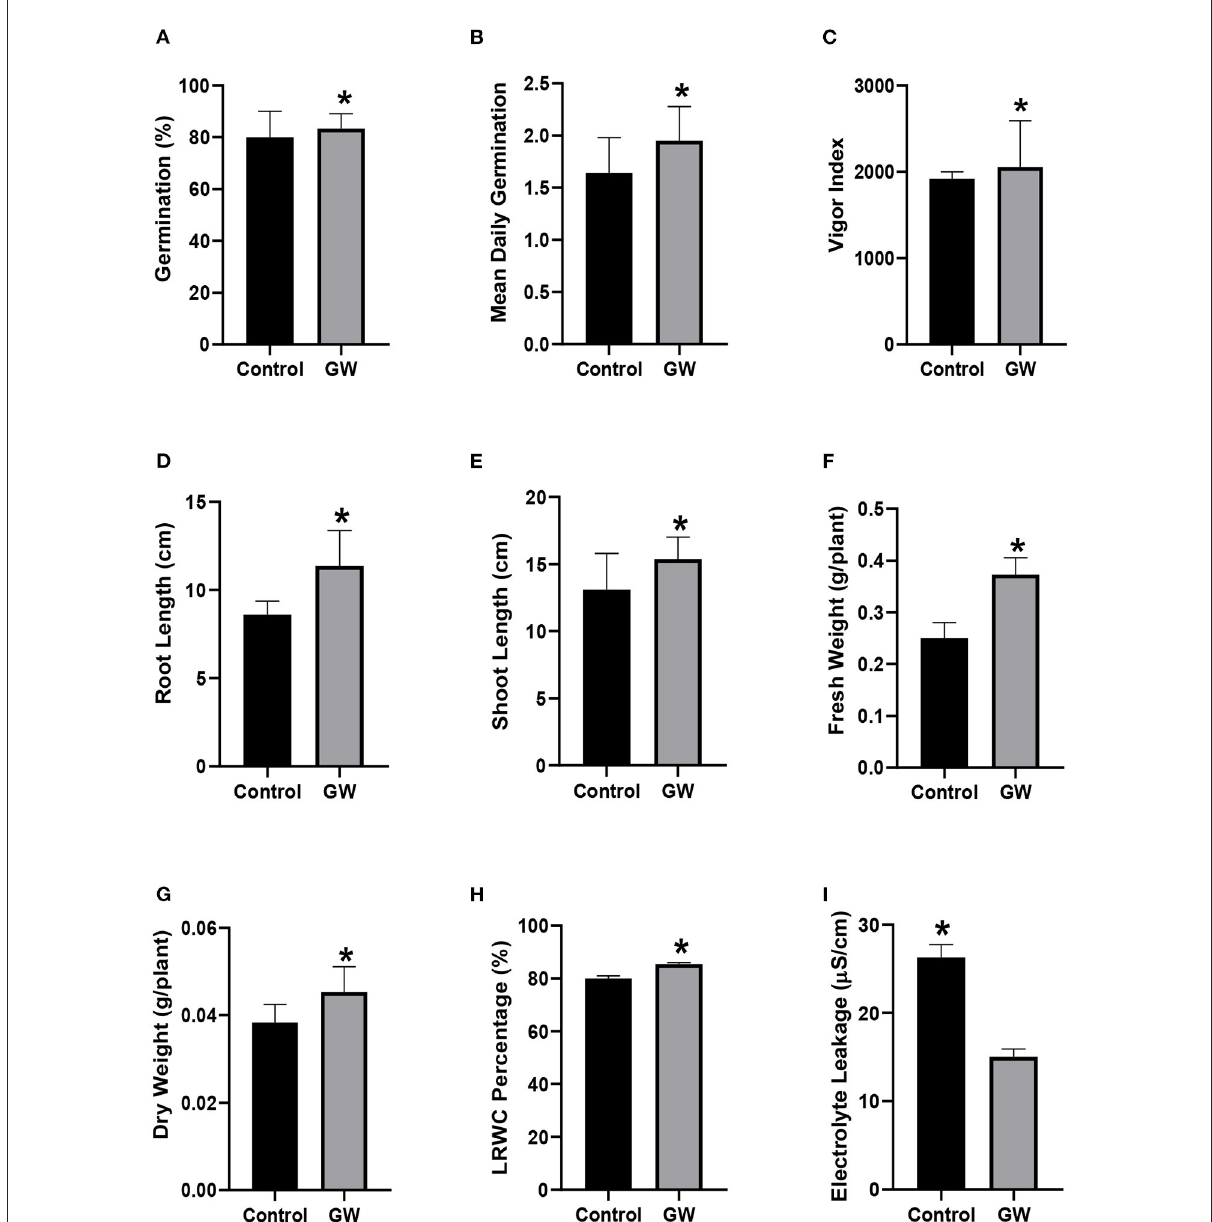
FIGURE9 Wheat biofertilization by F. oxysporum GW (A) germination percentage, (B) mean daily germination, (C) vigor index, (D) root length, (E) shoot length, (F) fresh weight, (G) dry weight, (H) LRWC, and (I) EC . Bars show the mean of three replicates with standard deviation. Bars labeled with * are significantly higher ( t -test; p <